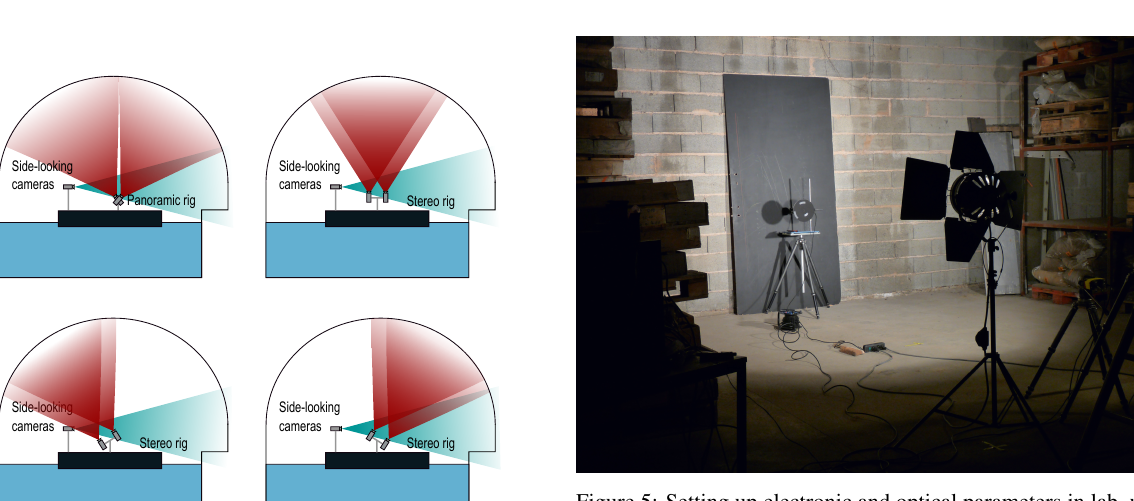
Figure 5: Setting up electronic and optical parameters in lab, us- ing a rotating disk under artificial